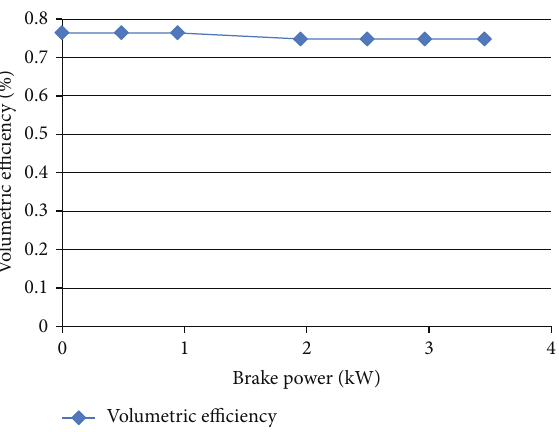
Figure 8: Volumetric efficiency versus brake power.